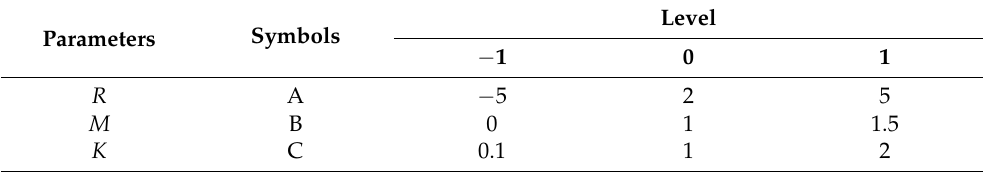
Table 1. Thermophysical properties of the blood and copper nanoparticles (see [27]). Properties Table 2. Parameters with their levels for Cf x ( − 1 ) . Parameters